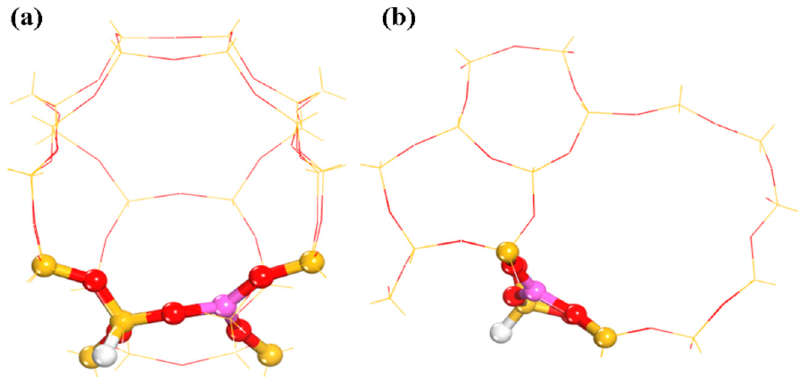
Figure 9. 32 T cluster model of a Lewis acid in the HZSM-5 zeolite. ( a ) Sinusoidal channel and ( b ) straight